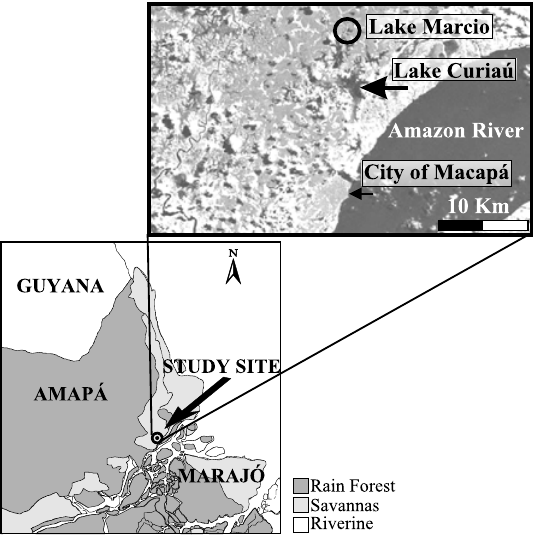
Fig. 1 – Map of the study area, showing the location of Lakes Curiaú